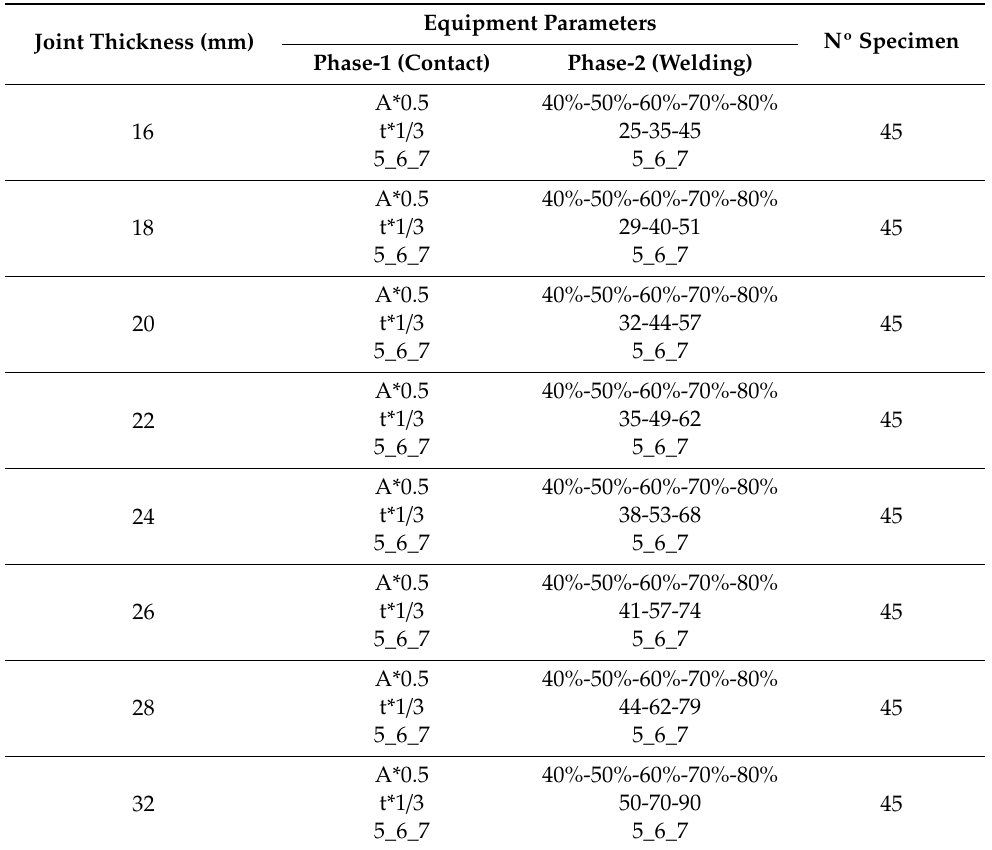
Table 2. The welding parameter commands for the A-t-p equipment.